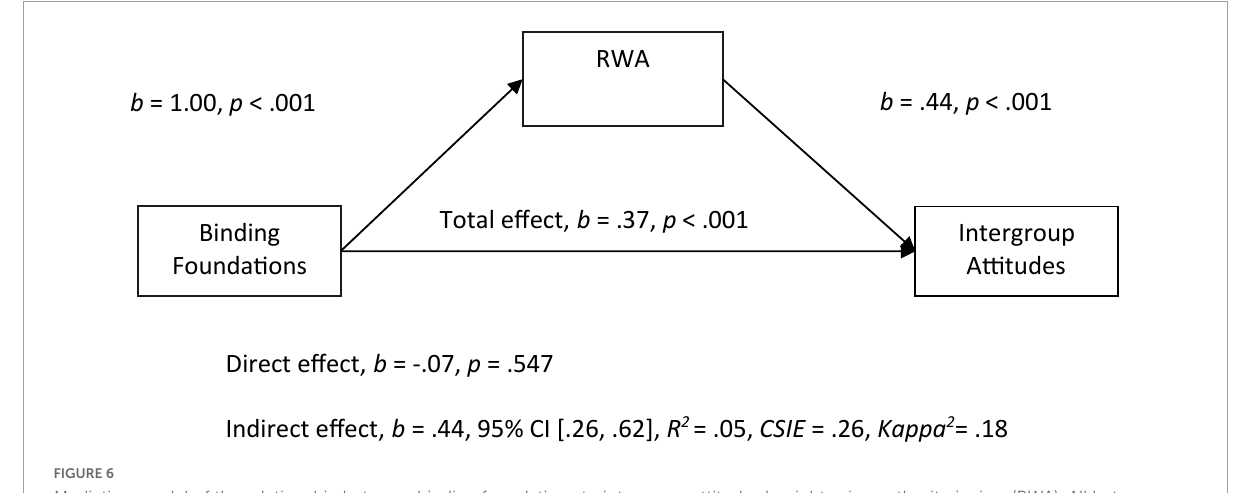
FIGURE6 Mediation model of the relationship between binding foundations to intergroup attitudes by right-wing authoritarianism (RWA). All betas represent unstandardized values from the Bootstrap analysis with 5,000 samples. CSIE represents the completely standardized indirect effect.